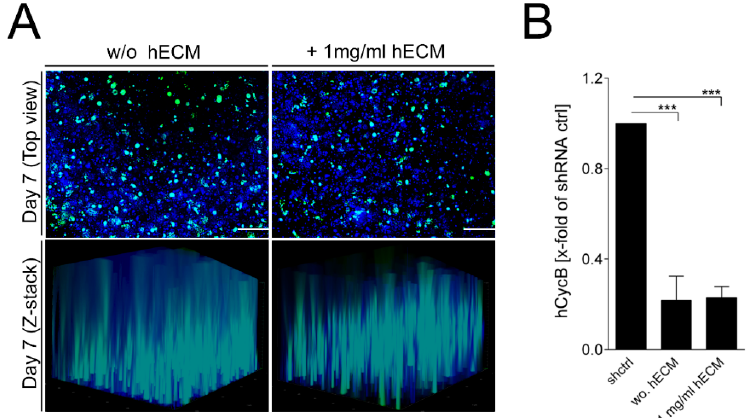
Figure 5. Adeno-associated virus (AAV) transduction and hCycB silencing in printed mature HepaRG cells in alginate/gelatin bioinks containing 1 mg/mL hECM. ( A ) Analysis of AAV2.6 vector transduction and distribution within mature HepaRG cell-laden 3D alginate/gelatin constructs, determined by fluorescence microscopy. Comparison of constructs with and without 1 mg/mL hECM seven days after printing. Nuclei were visualized by Hoechst staining (blue); the green fluorescence represents green fluorescent protein (GFP) expression of AAV vectors. Scale bar: 200 µm; ( B ) Analysis of shRNA-mediated hCycB RNA knockdown within the mature HepaRG cell-laden 3D alginate/gelatin constructs, determined by reverse transcription polymerase chain reaction (RT-qPCR). Comparison of constructs with and without 1 mg/mL hECM seven days after transduction. An shRNA control was used for normalization to assess the knockdown. Results are shown as mean ± SEM of three independent experiments. *** p ≤ 0.001.